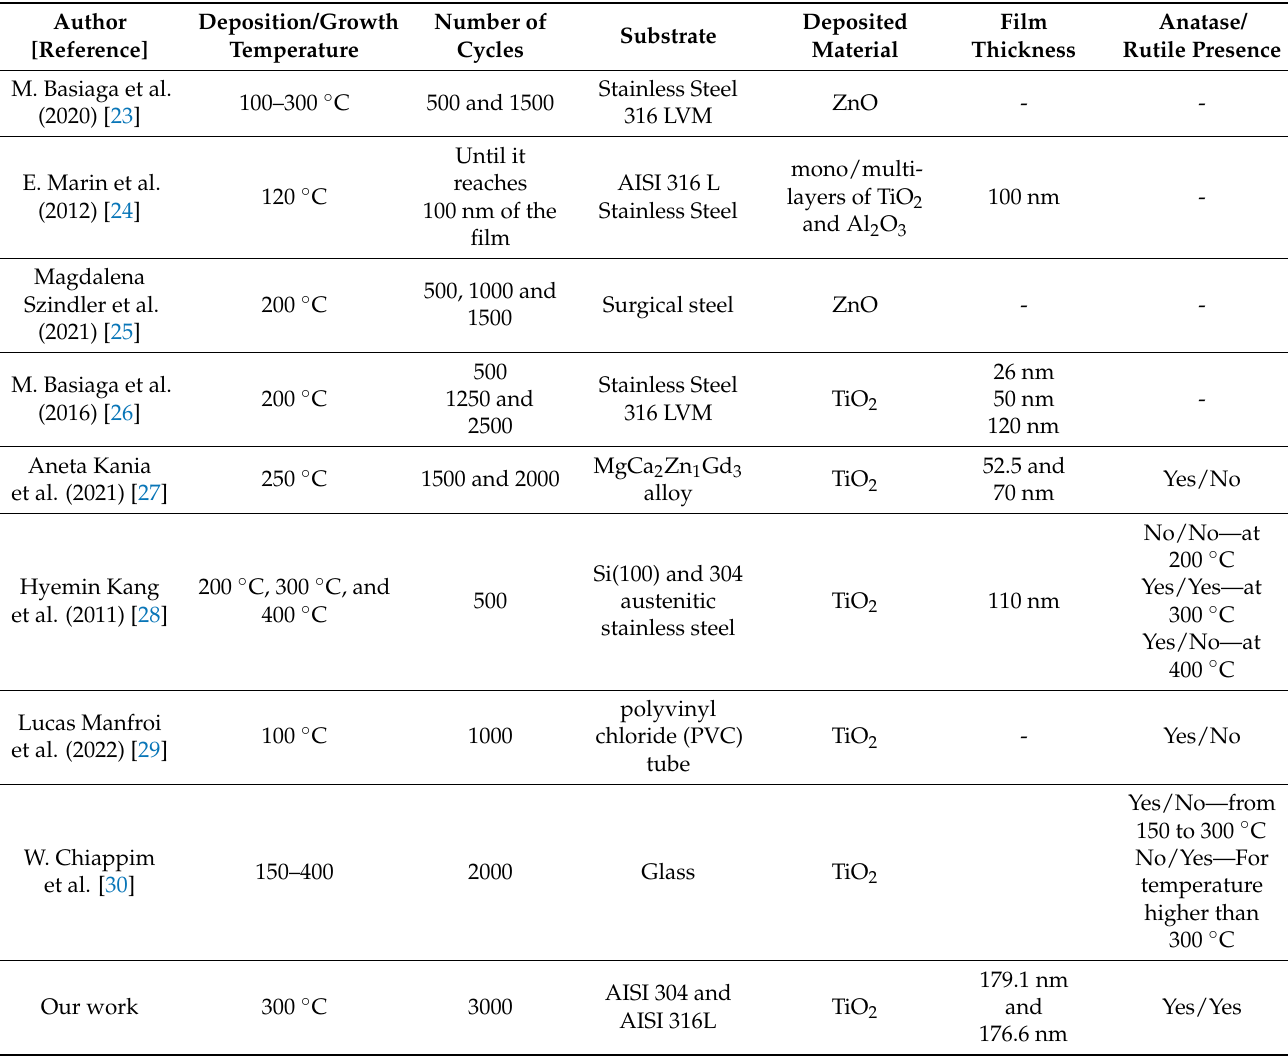
Table 1. Protocol comparison, substrates, film, and thickness